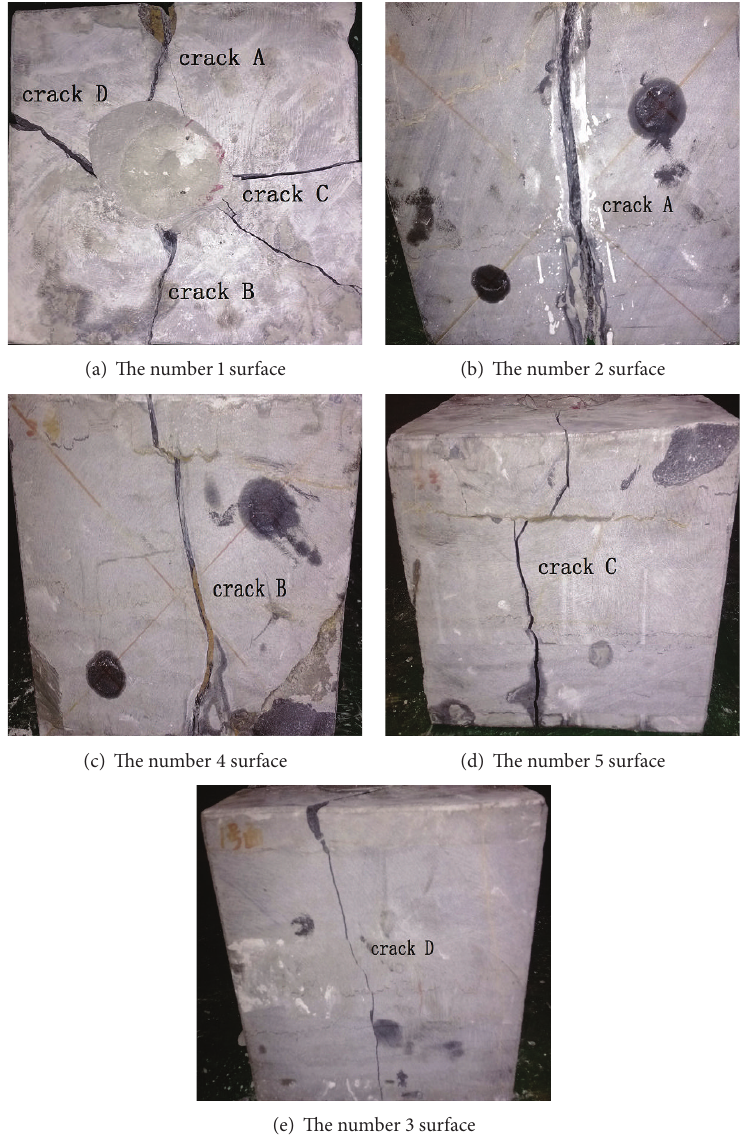
Figure 12: Crack expansion actual